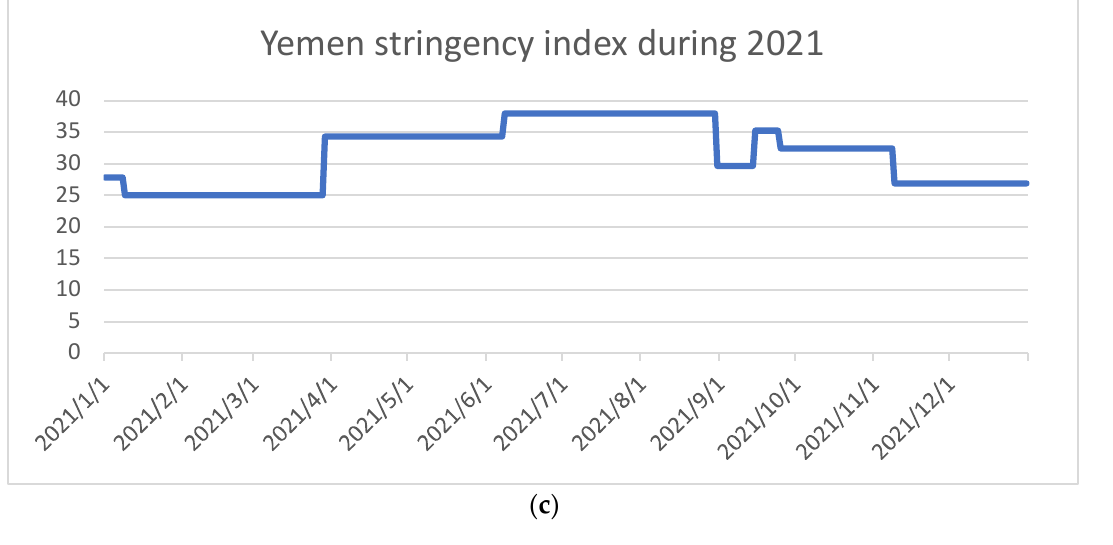
Figure 1. ( a ) Yemen Stringency Index; ( b ) Yemen Stringency Index from 10 April 2020 till the end of 2020; ( c ) Yemen Stringency Index during 2021.